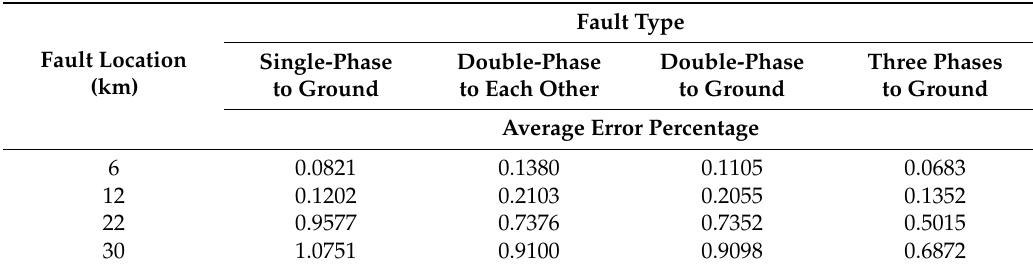
Table 5. Results of running the proposed algorithm considering measurement